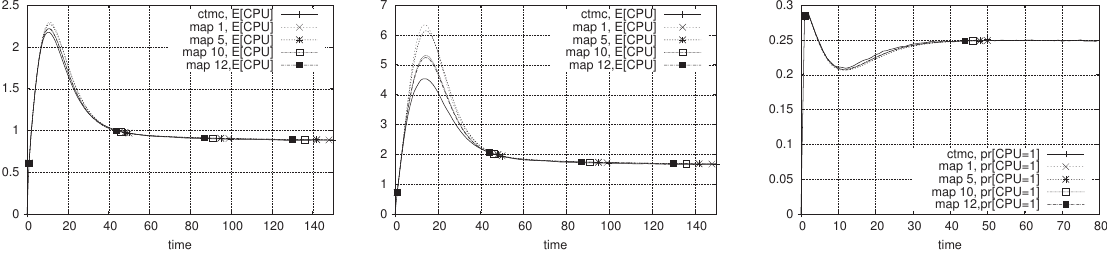
Figure 12: Expected number and variance of requests, and probability of having one request at the CPU station as function of time using a model composed of load-dependent stations.